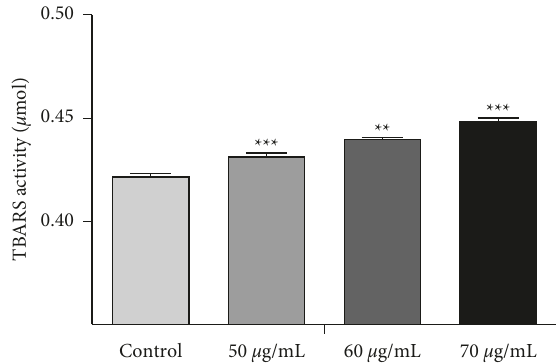
Figure 13: Concentration of lipid peroxidation level in A549 cell line after treatment of various concentrations of SP-ZnONPs.